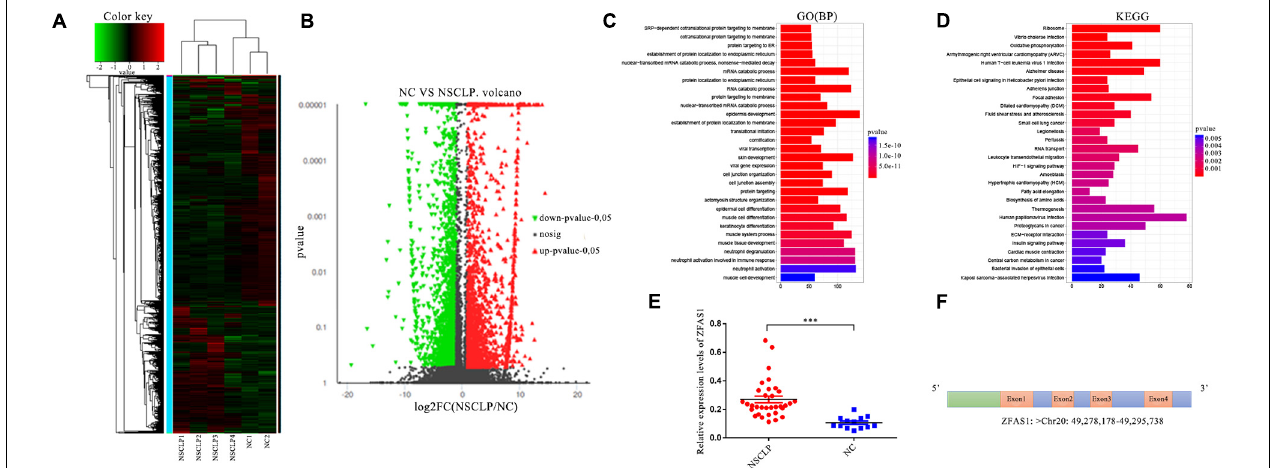
FIGURE 1 | ZFAS1 was screened through long non-coding RNA (lncRNA) sequencing and further qPCR assay. (A) Heatmap of dysregulated lncRNAs identified from lncRNA sequencing by hierarchical clustering analysis between the non-syndromic cleft lip and palate (NSCLP) (NSCLP1/2/3/4) and normal control (NC) (NC1/2) samples. Expression values are represented by red and green shades, indicating expressions above and below the median expression level across all samples, respectively. (B) The volcano plot of differentially expressed lncRNAs. The fold change threshold is 1.5, and P -value ≤ 0.05. The red dots indicate upregulated genes, the green dots indicate downregulated genes, and the black dots indicate non-differentially expressed genes. (C,D) The gene ontology (GO) and Kyoto Encyclopedia of Genes and Genomes (KEGG) pathways significantly enriched in the differentially expressed lncRNAs. The length and color of the bar represent the amount of differentially expressed lncRNAs enriched in the pathway and enrichment significance, respectively. BP, biological processes. (E) ZFAS1 was upregulated in tissues from NSCLP compared with NC tissues by qPCR assay. (F) The schema of ZFAS1 in chromosome. Values are mean ± SEM, n = 3, *** P < 0.0001.